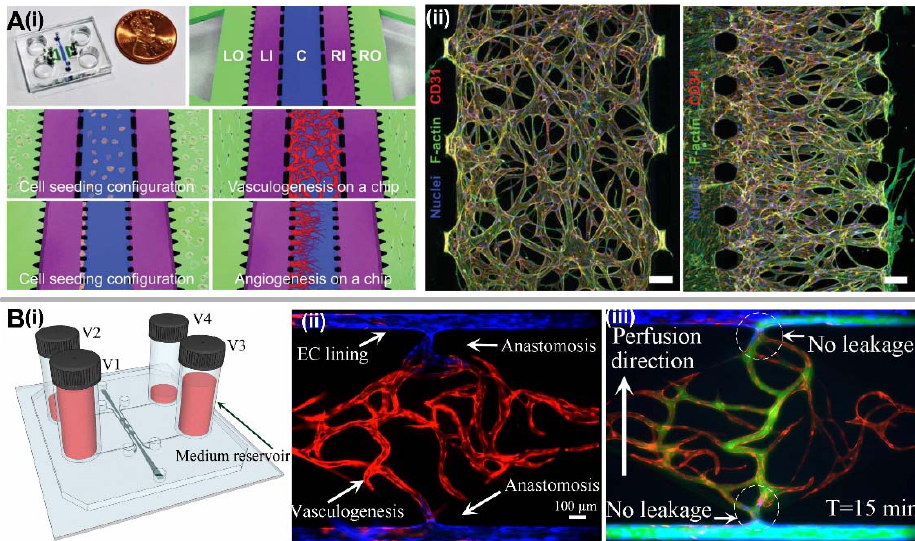
Figure 3. Hybrid methods for in vitro vascularization. ( A ) Vasculogenesis or angiogenesis realized on a single microfluidic device. ( i ) Schematic of microfluidic chip design and cell seeding configurations for vasculogenesis and angiogenesis at different microfluidic channels. ( ii ) Confocal micrographs showing the overall architectures of vascular networks established by vasculogenic and angiogenic processes at day 4. Scale bar, 100 μ m. Adapted by permission from Reference [54], copyright Royal Society of Chemistry 2013. ( B ) Advanced vascularization model for generating an intact and perfusable 3D microvascular network. ( i ) Schematic of microfluidic device design by using four medium reservoirs with different hydrostatic pressures. ( ii ) Intact microvascular network formation that incorporates different stages of vascular development including vasculogenesis, EC lining, sprouting angiogenesis, and anastomosis in sequential order. ( iii ) 70 kDa FITC-dextran perfusion confirms physiologic tightness of the EC junctions and completeness of the interconnections between artery/vein and the capillary network. Adapted by permission from Reference [26], copyright Royal Society of Chemistry